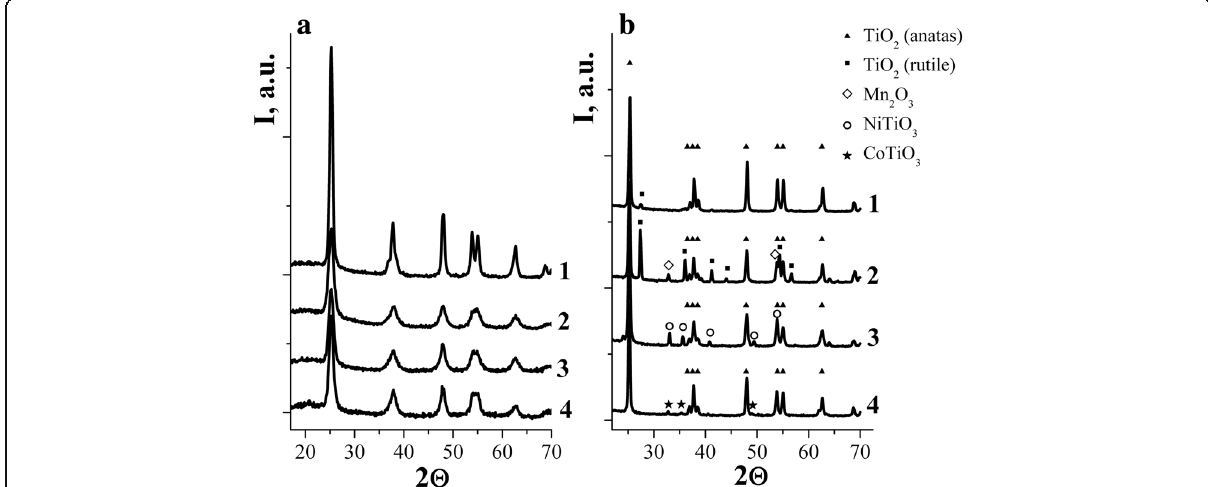
Fig. 2 XRD patterns of Cu/TiO 2 ( 1 ), Mn/TiO 2 ( 2 ), Ni/TiO 2 ( 3 ), and Co/TiO 2 ( 4 ) powders doped with 5% of metal ions calcined at 450 ( a) and 650 °C (